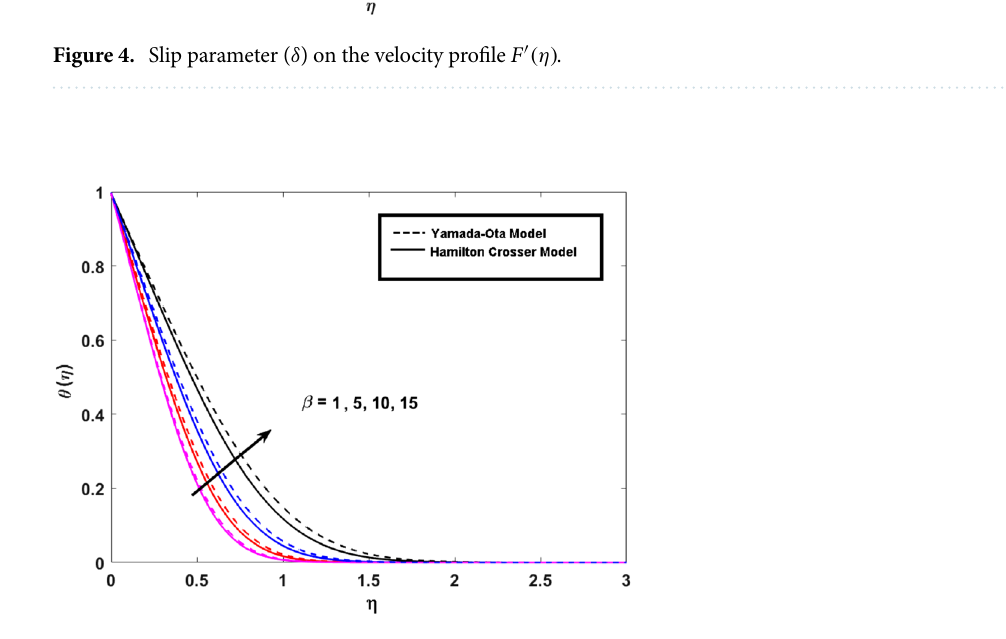
Figure 5. Hydrodynamic interaction ( β ) on the thermal profile θ(η)